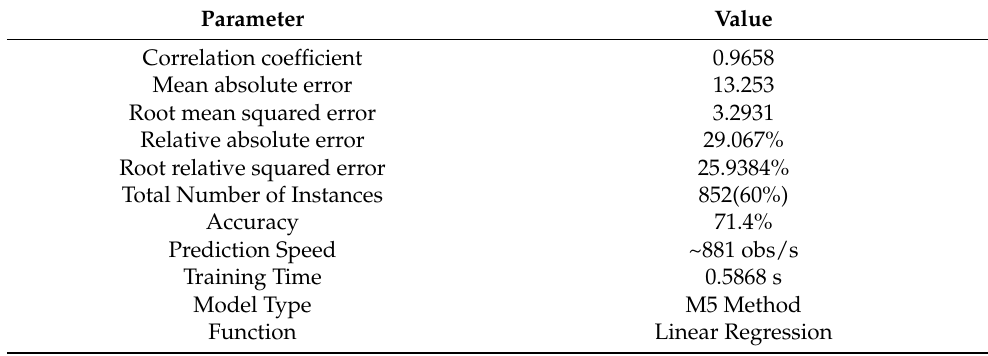
Table 5. Linear Regression